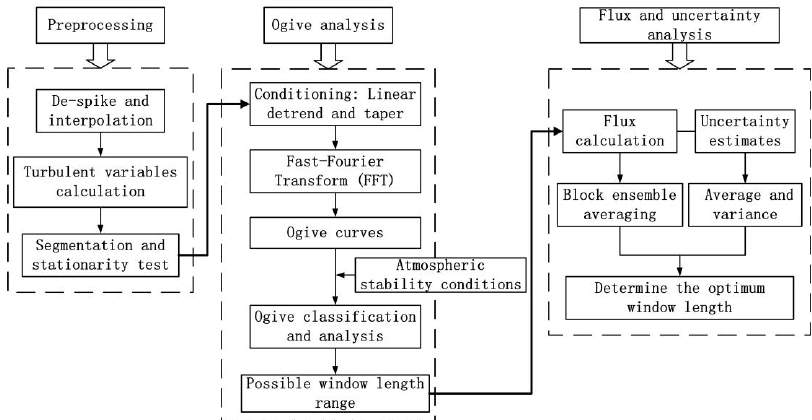
Figure 2. Diagram of the methodological framework of this study.